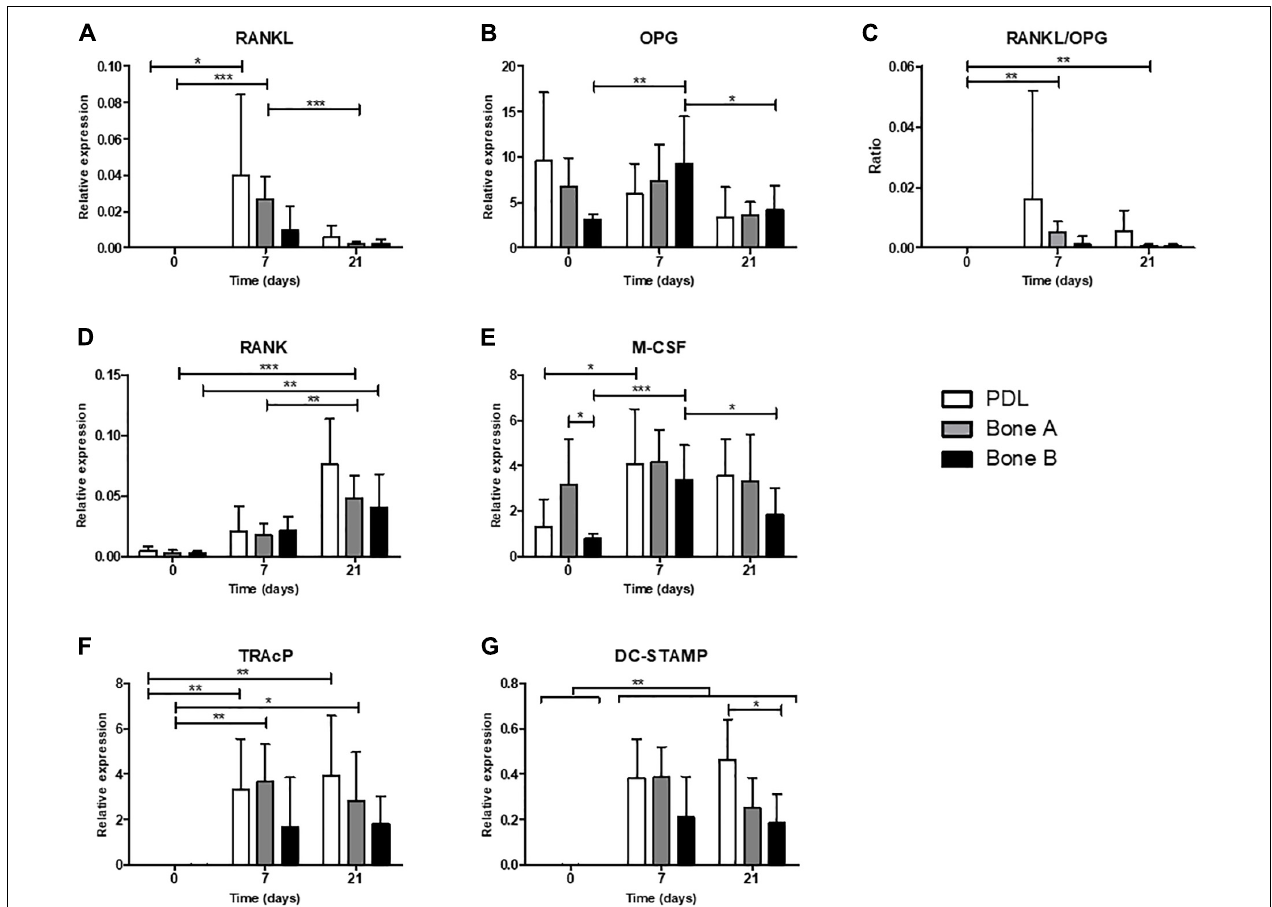
FIGURE 9 | Osteoclastogenesis and osteoclast genes. Gene expression was assessed in absence of PBMCs (day 0) and after co-culturing with PBMCs (day 7 and 21) for PDL, bone A and bone B. Gene expression of (A) RANKL, (B) OPG, (C) RANKL/OPG ratio, (D) RANK, (E) M-CSF, (F) TRAcP, and (G) DC-STAMP are shown relative to housekeeping gene HPRT. Note the difference in scale of the y-axes. Means ± SD are shown ( n = 7). * p < 0.05; ** p < 0.01; *** p < 0.001 [One-way ANOVA (repeated measures) with a Tukey’s multiple comparison post hoc